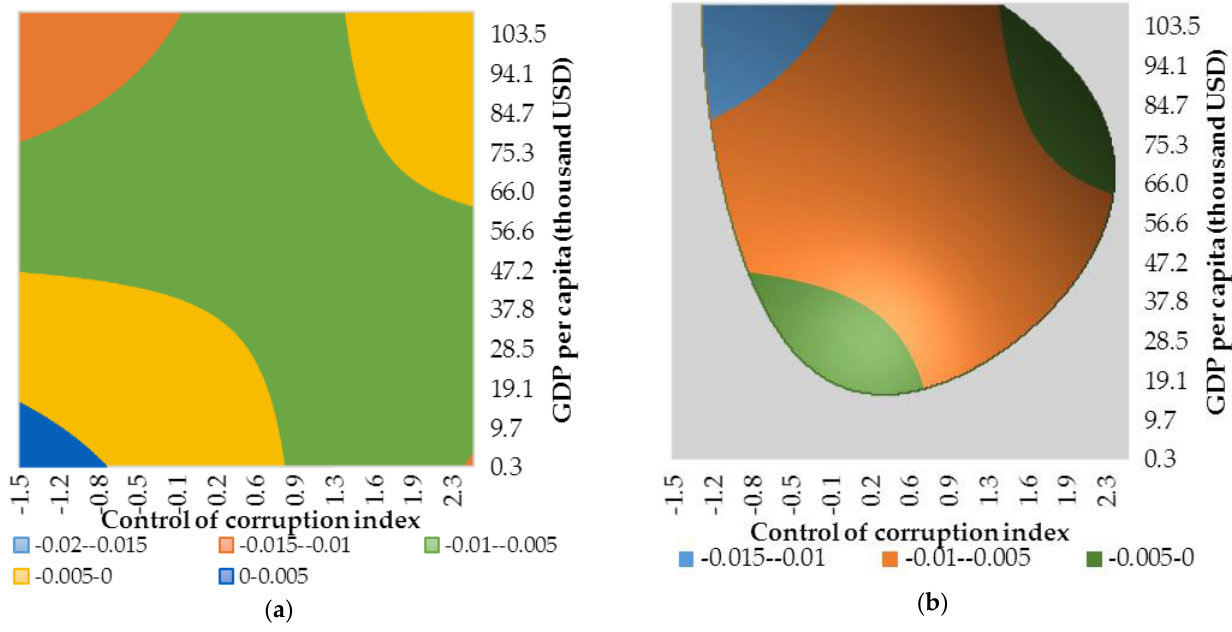
Figure A19. Conditional effect of financialisation on growth based on Est. 19 in Table A2. ( a ) Estimated conditional slope coefficient over the whole range of observed values for institutional quality and development level. ( b ) Estimated statistically significant conditional slope coefficient. Gray represents a combination of institutional quality and development level for which effect of financialisation on growth is statistically insignificant. Source: authors’ contributions.